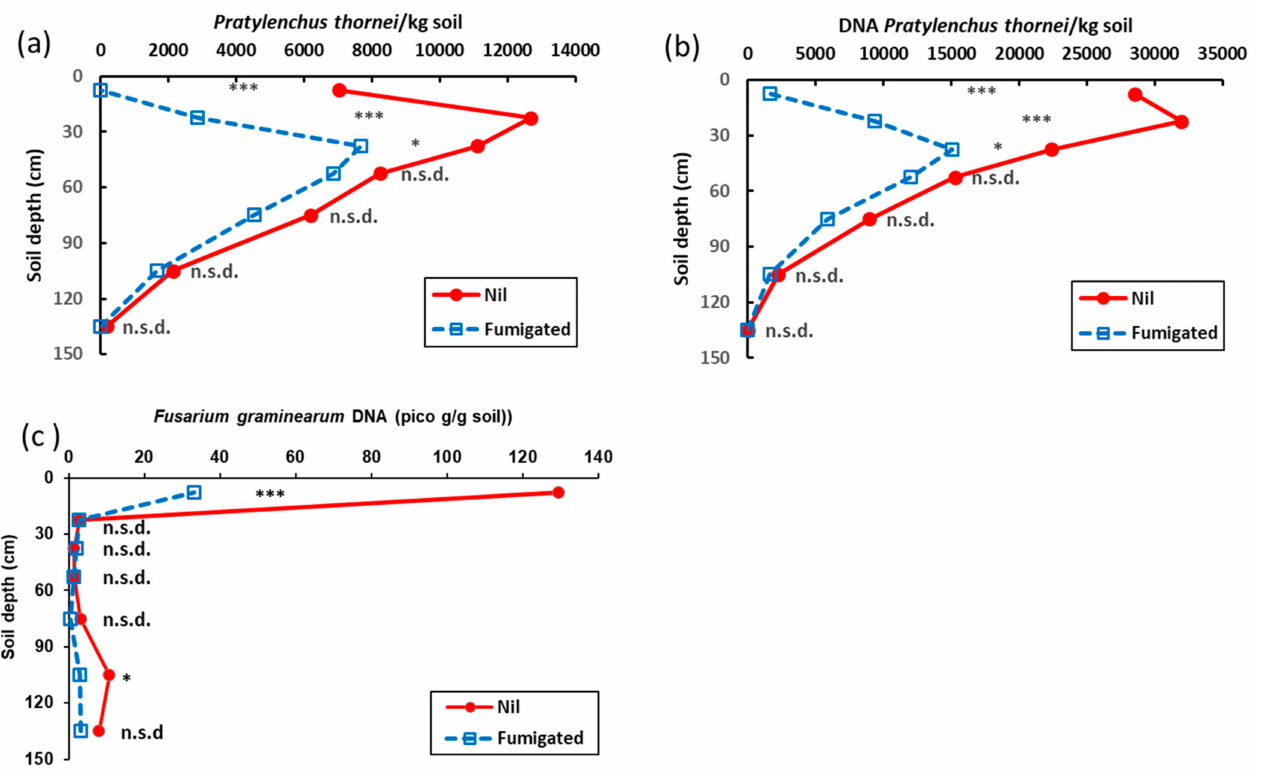
Figure 11. Effect of fumigation with methyl bromide on population densities of Pratylenchus thornei in the soil profile before sowing Experiment 4, ( a ) P. thornei determined by extraction and counting microscopically, ( b ) P. thornei determined by DNA quantification, and ( c ) Fusarium pseudograminearum determined by DNA quantification. Points are the back-transformed values from means of ln(x+1) transformations ( n = 15), where significant differences between transformed means for nil and fumigated treatments at the respective depth interval are indicated as * = p < 0.05, *** = p < 0.001.